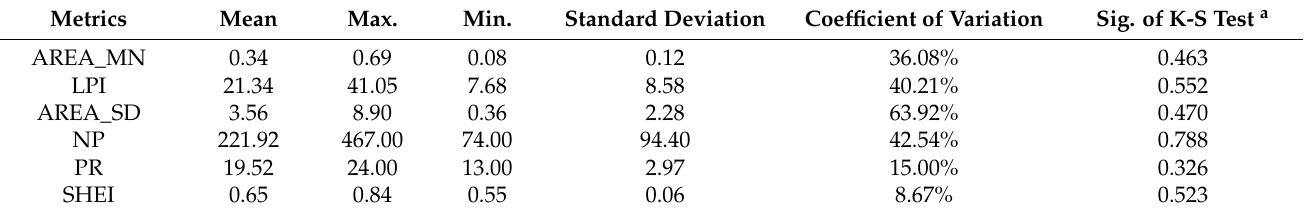
Table 3. Metrics values of landscape color structure of the Cotinus coggygria var. cinerea Engl. forest.